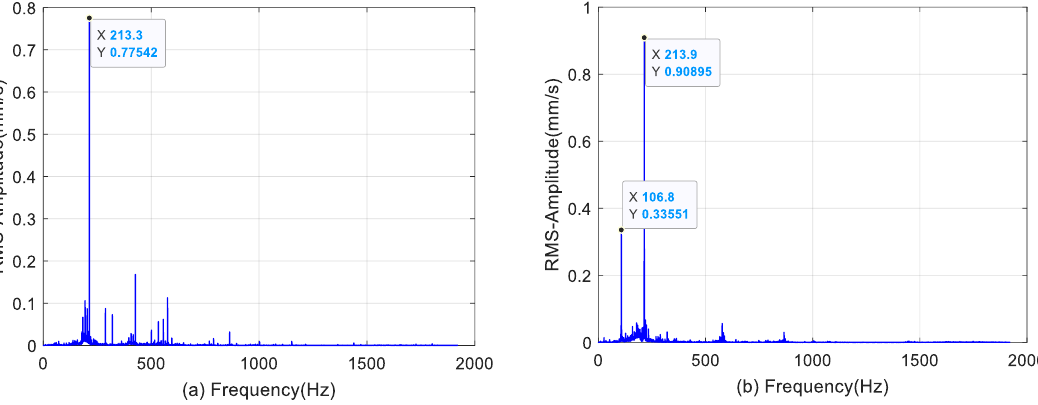
Figure 15. Experimental frequency response of the imbalanced rotor ( a ) without water and ( b ) with water.